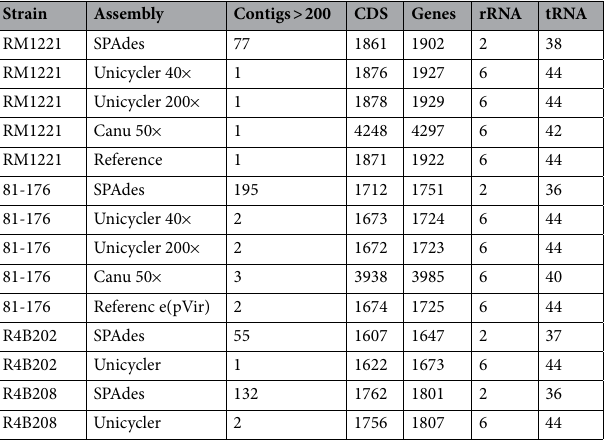
Table 8. Prokka annotation features. Prokka was used to annotate the genome assemblies and reference genomes to identify coding sequences (CDS) and genes. The 81-176 reference genome included both the chromosome and pVir plasmid